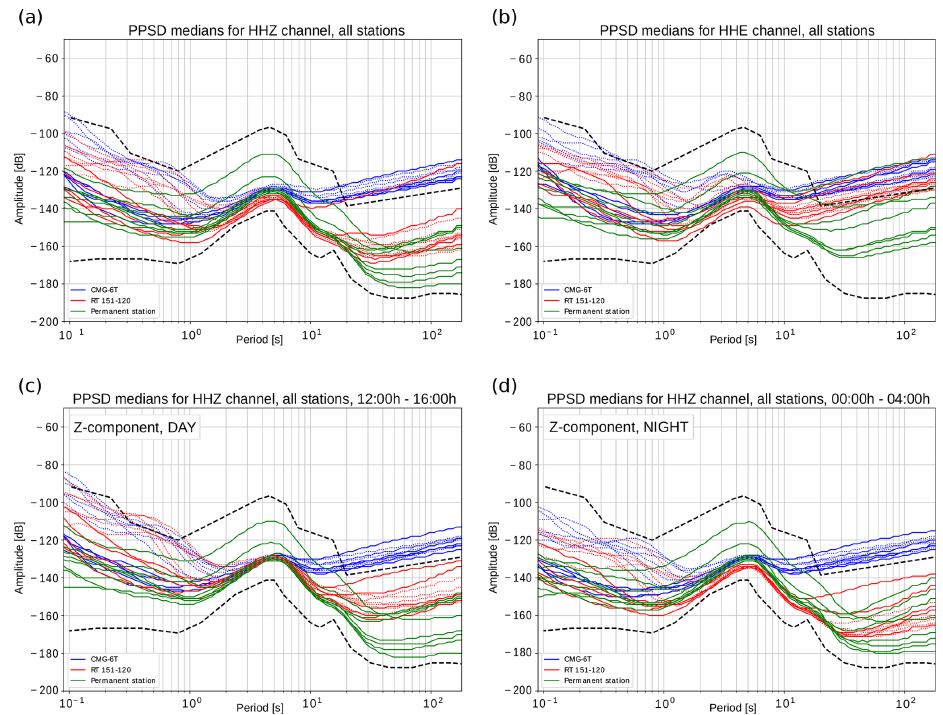
Figure 13. The PPSD median curves for all temporary and permanent stations. (a) Z component, (b) E component, (c) Z component, daytime hours only (12:00–16:00LT), (d) Z component, nighttime hours only (00:00–04:00LT). Dotted lines – stations located on Quaternary sediments, solid lines – stations located on Palaeozoic or older basement. Time span for calculation is 22 months (from January 2018 to October 2019). Black lines mark new high and low noise models (NHNM, NLNM; Peterson,